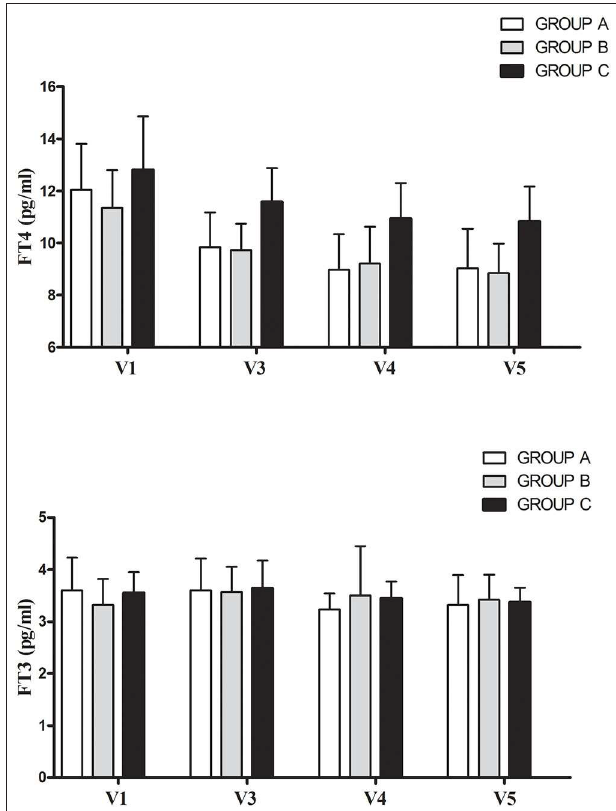
SD ) changes of free thyroid hormone before (V1) and FIGURE 2 | Mean ( + during L-T4 T3S therapy in the 34 patients who maintained the same T3S + dose throughout the entire study. The various groups are labeled according to the T4/T3S ratio of their treatment regimen: group A group C =